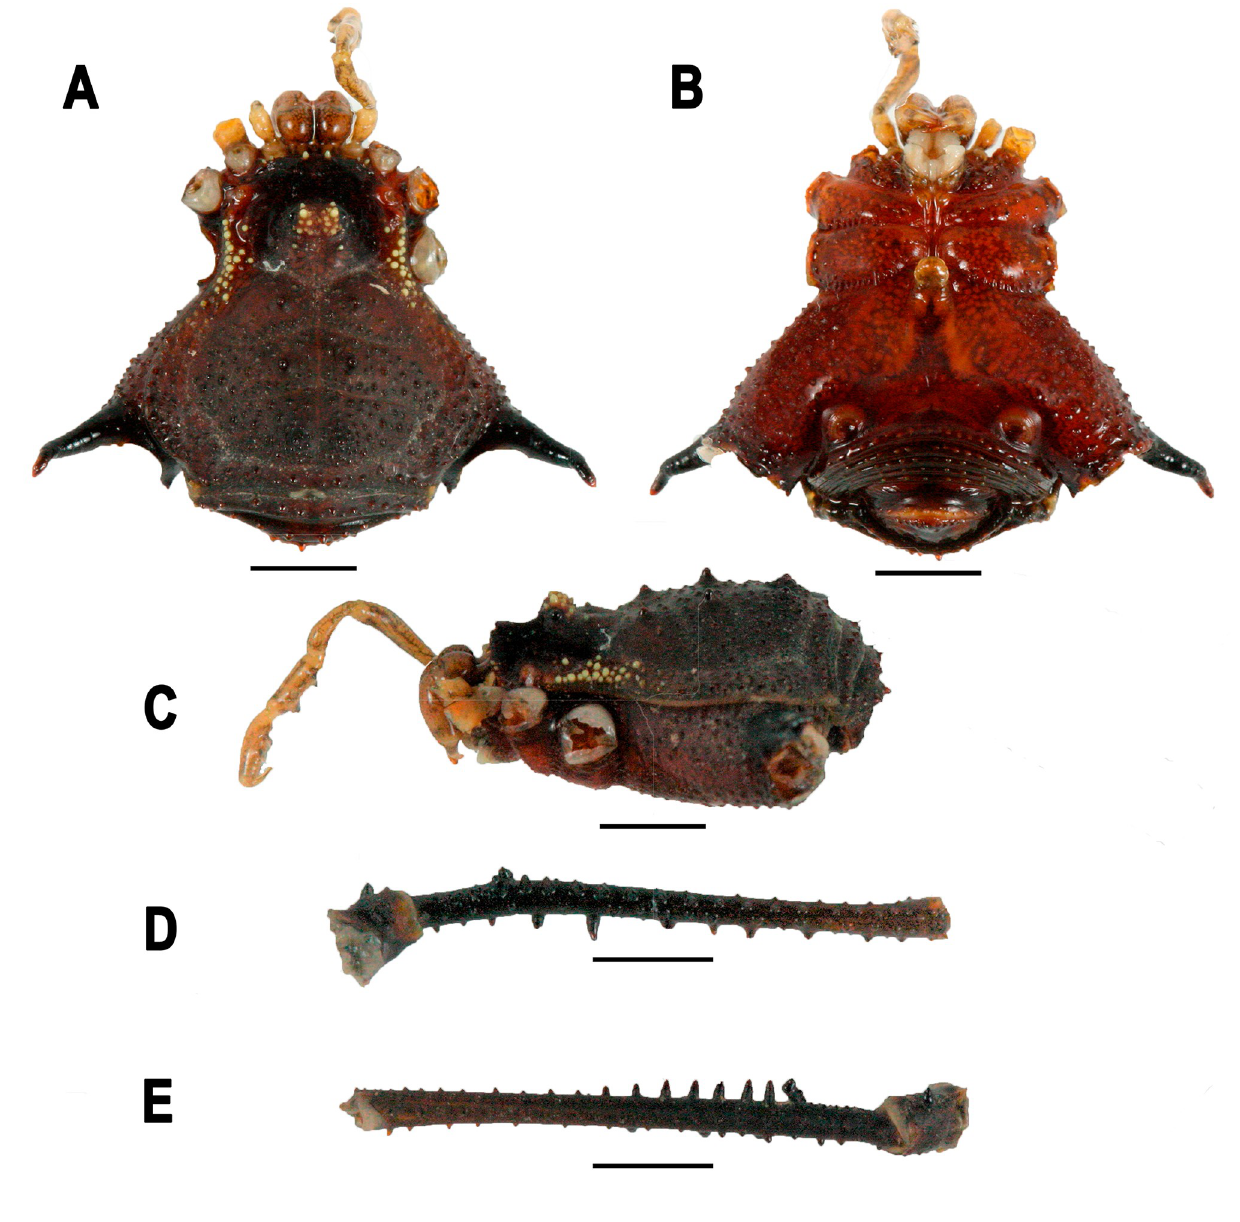
Fig 8. Neosadocus maximus (male voucher specimen, MZSP 76344). A. Dorsal view. B. Ventral view. C. Left lateral view. D–E. Right trochanter–femur IV (D: retrolateral view; E: prolateral view). Scale bars: 3